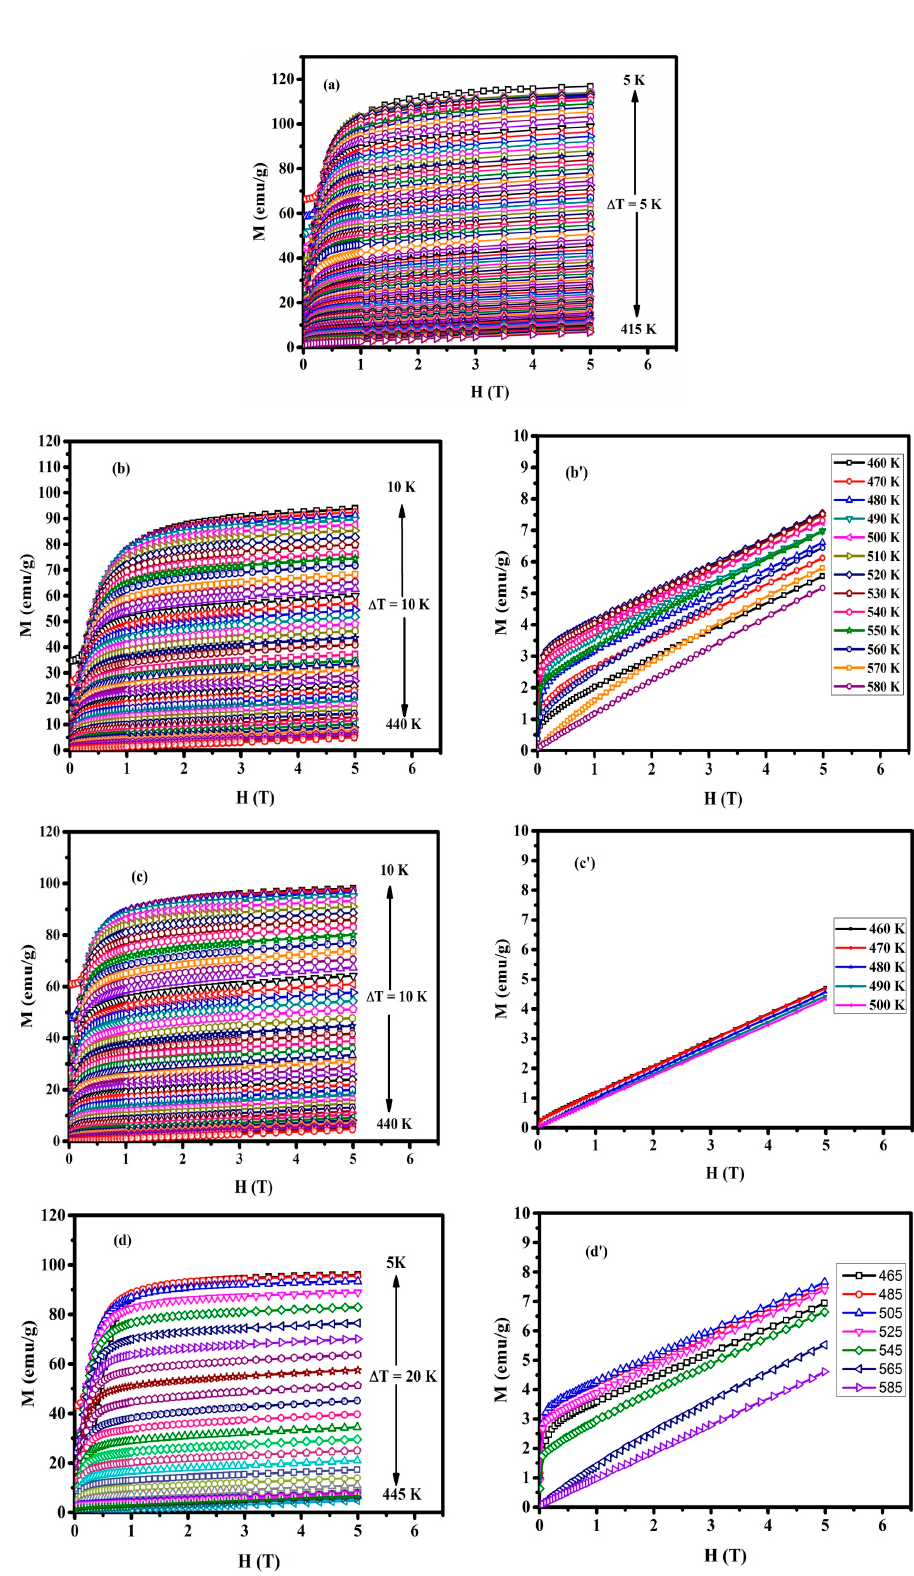
Figure 5. Variation of magnetization versus the applied magnetic field up to 5T at different temperatures for ( a ) Er(Fe 0.8 Mn 0.2 ) 2 , ( b , c , d ) at the temperature range T < T comp and ( b’ , c’ , d’ ) at T > T comp for (Fe 0.8 Mn 0.1 Co 0.1 ) 2 , Er(Fe 0.7 Mn 0.2 Co 0.1 ) 2 , and Er(Fe 0.7 Mn 01 Co 0.2 ) 2 , respectively.